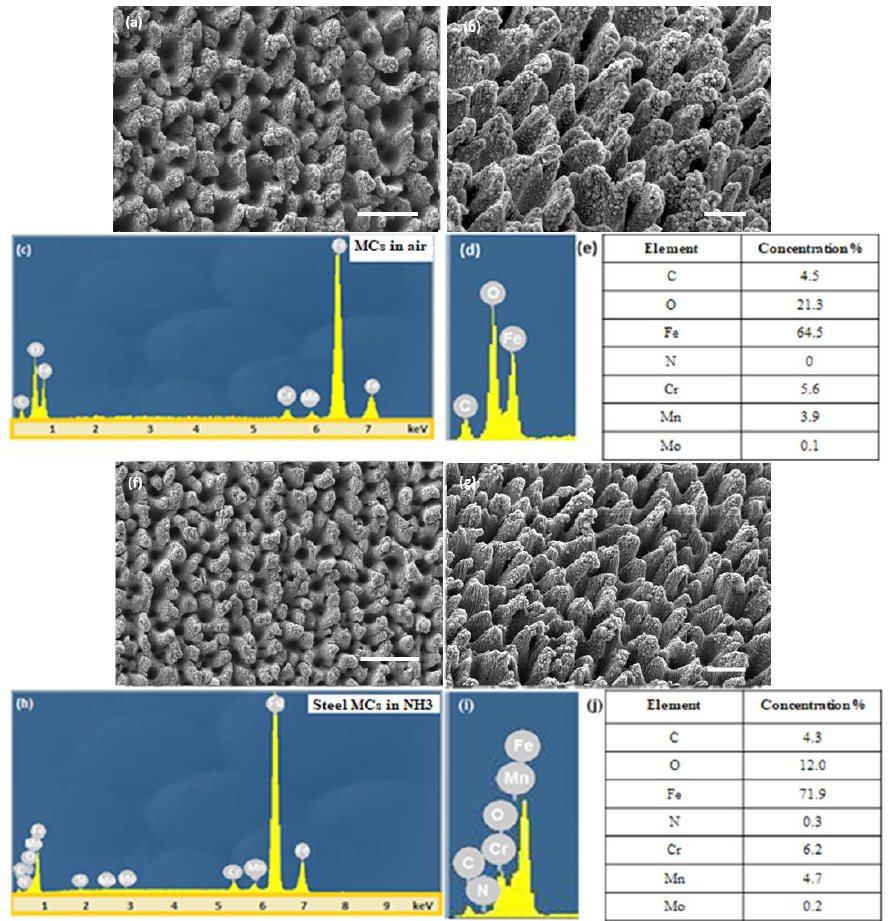
Figure 2. Top-view ( a ) and 45 ◦ -tilted ( b ) SEM images of steel surfaces fabricated in air at a fluence of 0.73 J / cm 2 (scale bars: 50 µ m and 20 µ m, respectively); ( c , d ) EDS spectra from the area shown in (a). The corresponding elemental analysis is shown in ( e ); Top-view ( f ) and 45 ◦ -tilted ( g ) SEM images of steel surfaces fabricated in NH 3 atmosphere at a fluence of 0.73 J / cm 2 (scale bars: 50 µ m and 20 µ m, respectively); ( h , i ) EDS spectra from the areas shown in ( f ). The corresponding elemental analysis is shown in ( j ).